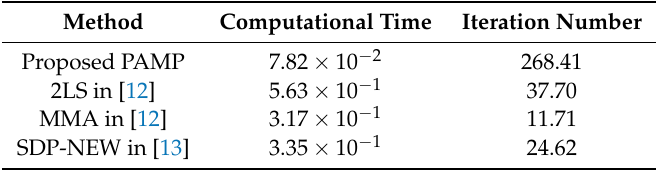
Table 5. Average computational time (in seconds) and average iteration number in scenario 2, uniformly distributed noise.